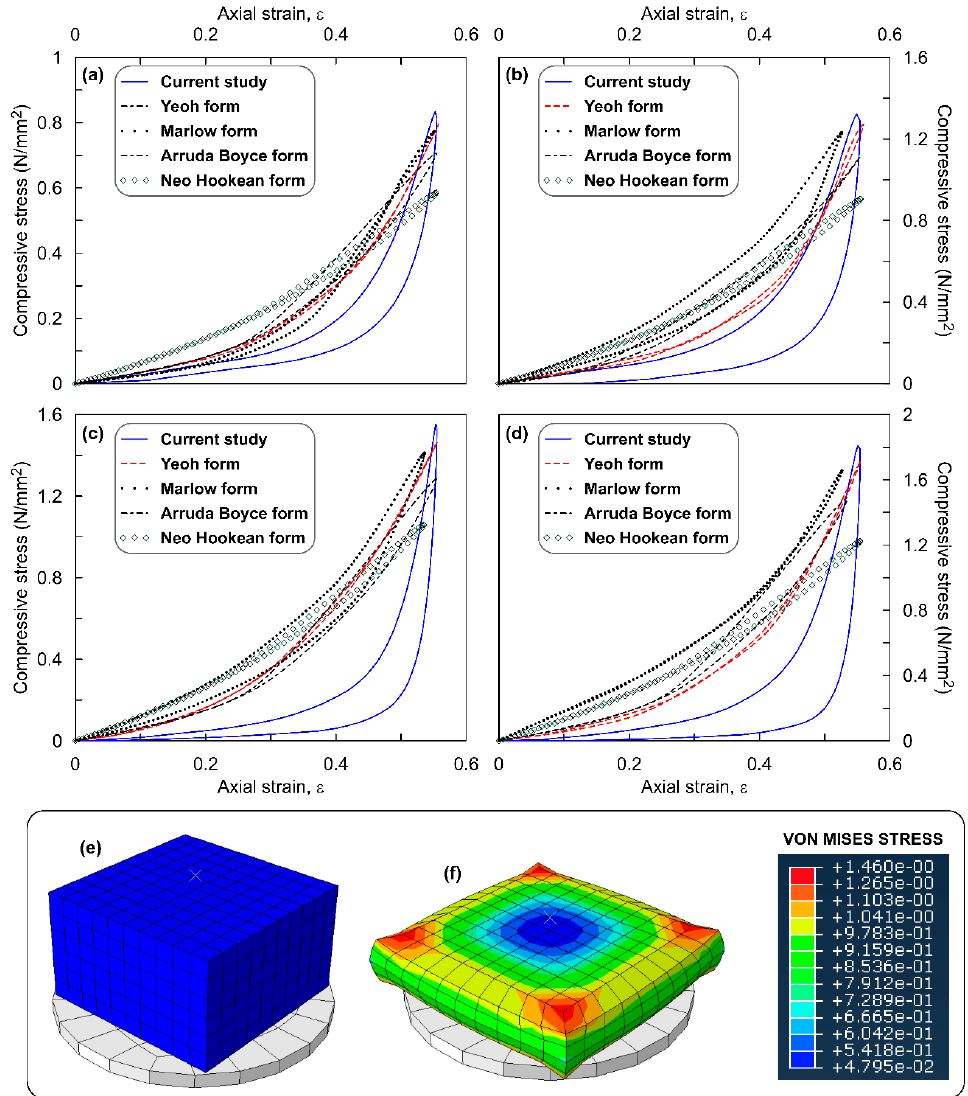
Figure 5. Stress–strain response of square shaped ROPS specimens: ( a ) 0% OPS; ( b ) 5% OPS; ( c ) 10% OPS; ( d ) 20% OPS; ( e ) un-deformed model; ( f ) deformed model with stress contours at ε ≈ 50%.